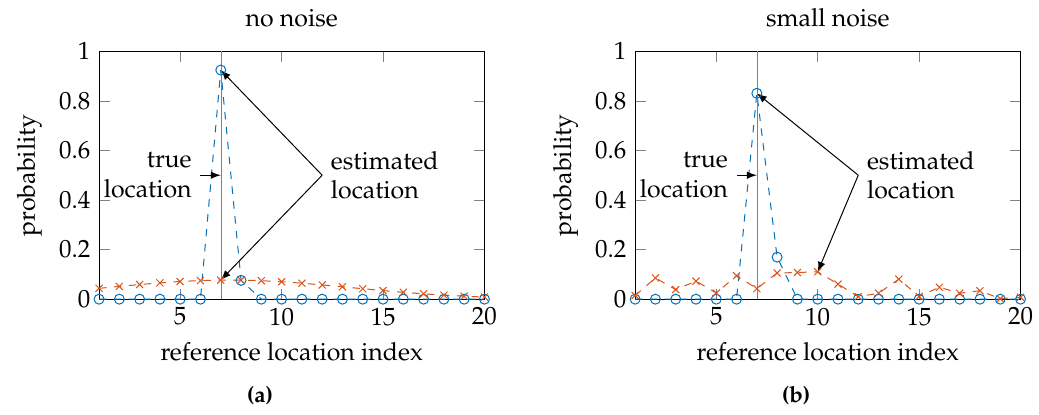
Figure 5. A small amount of white noise has little influence on the probability mass function with little uncertainty (the blue circles); the noise has much more influence on the function with high uncertainty (the red crosses). The dashed connecting lines have been added as visual aids. We want to know if low uncertainty also corresponds with low location